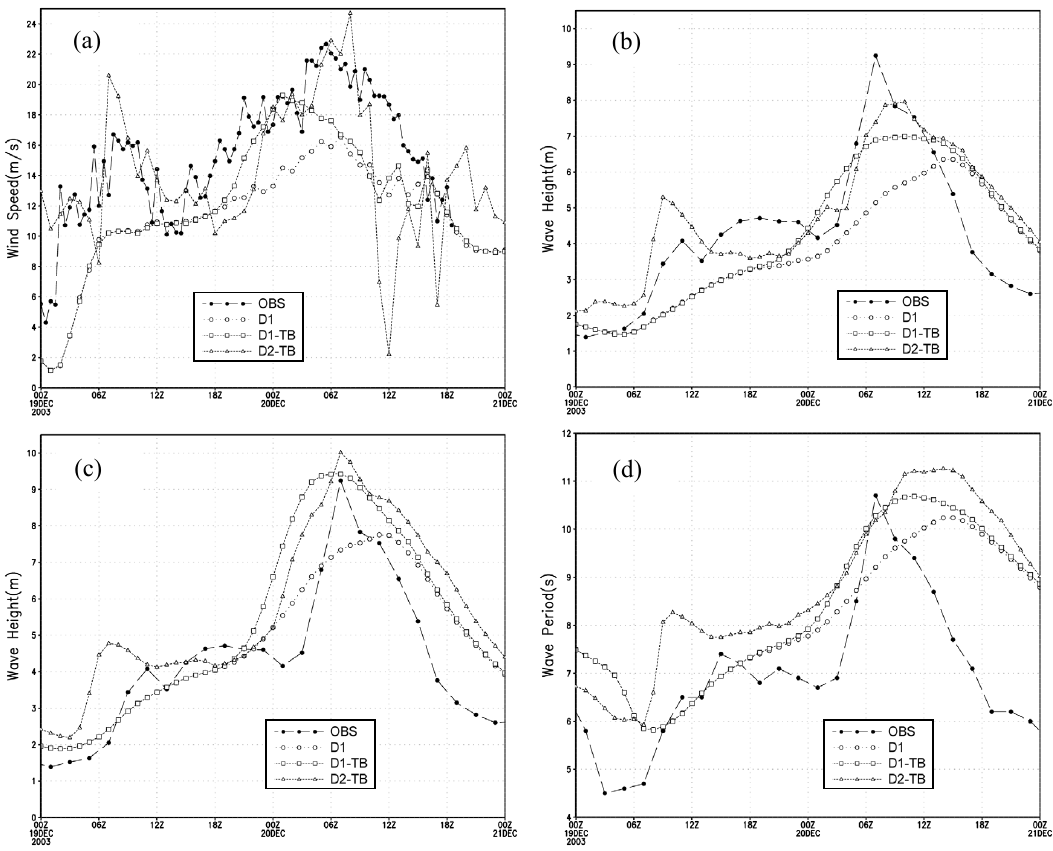
Fig. 5. Comparisons between observed and computed values from the abnormal storm wave event in December 2003. (a) Observed (propeller anemometer) U 10 wind speed at OWO and computed (D1, D1-TB, D2-TB cases) wind speed at Naoetsu, (b) observed (JMA) and computed (D1, D1-TB, D2-TB cases) significant wave heights at Naoetsu, (c) observed (JMA) and computed (D1, D1-TB, D2-TB cases) significant wave heights at P1 (see Fig. 4 for its location), and (d) observed (JMA) and computed (D1, D1-TB, D2-TB cases) significant wave periods at Naoetsu.